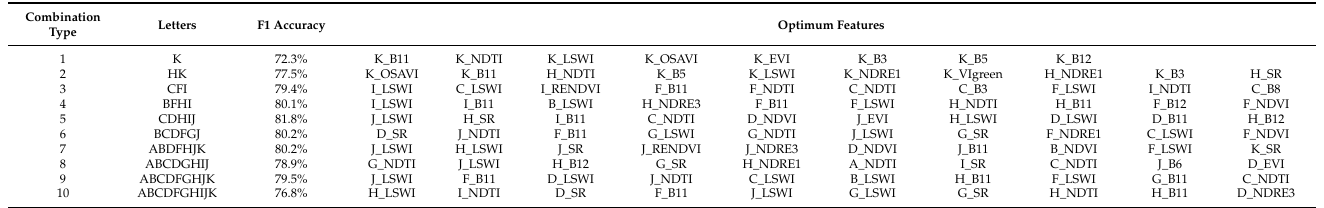
Table A11. Top-10 optimal soybeans feature sets for different combination types on 12 June